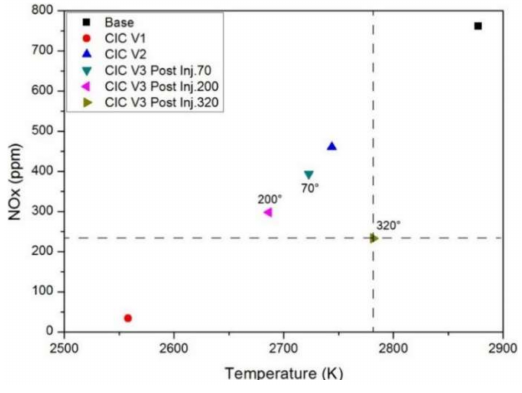
Figure 14. Comparison on NO x emission for different variable valve control strategies.